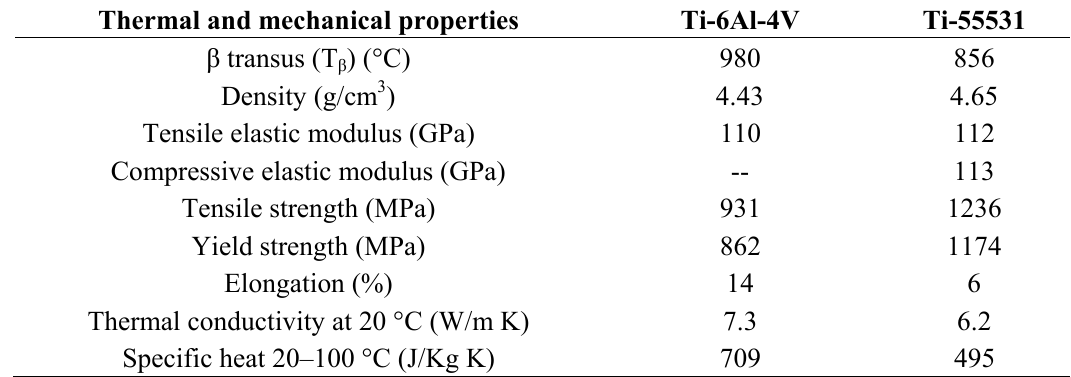
Table 2. Mechanical and thermal properties of Ti-6Al-4V and Ti-55531.